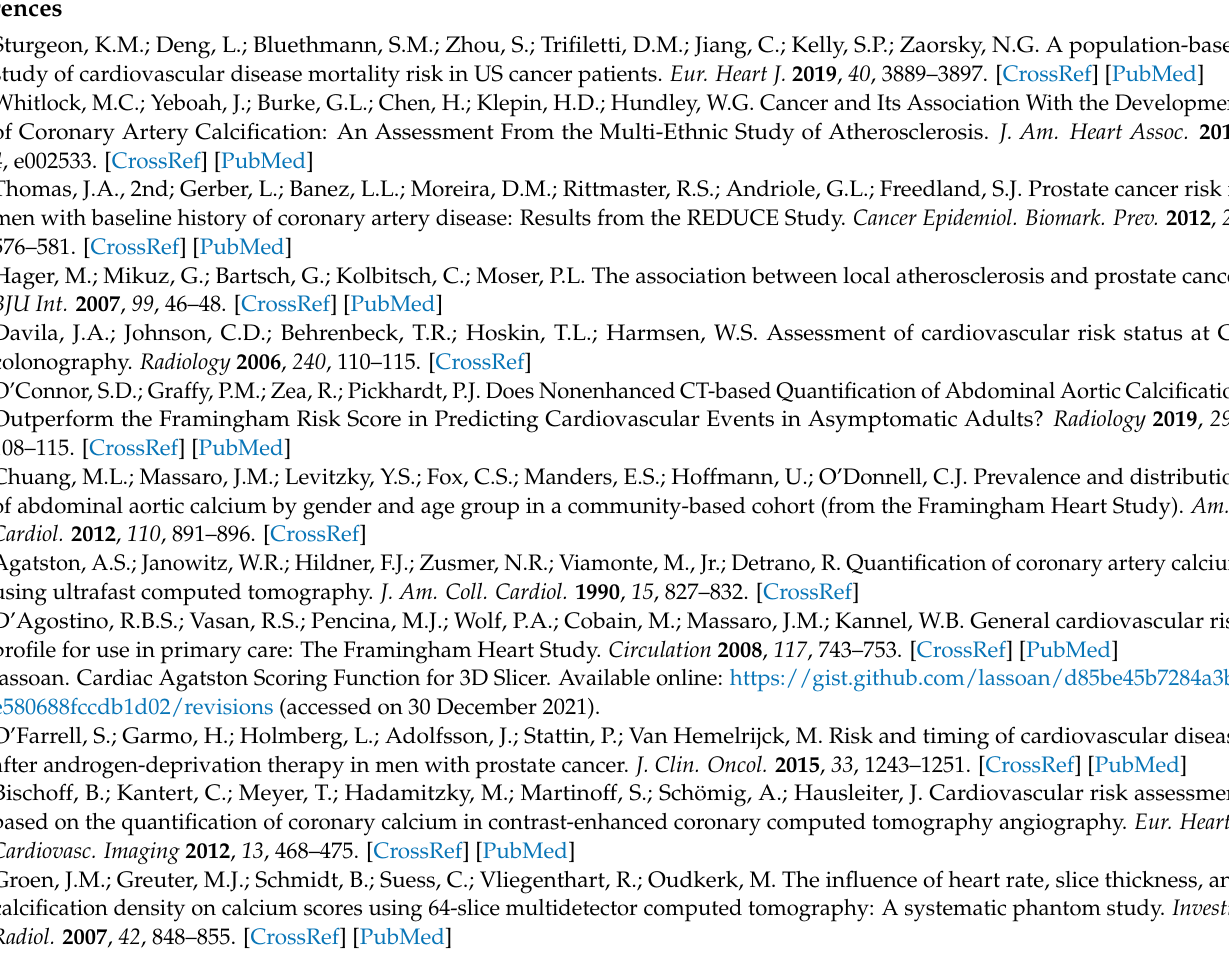
CT scans, Figure S5: Data augmentation of Agatston score measurements using ‘Split islands to segments’ in 3D Slicer, Figure S6: The conversion factor of Agatston scores between non-contrast and portal venous phase CECT in multiphase